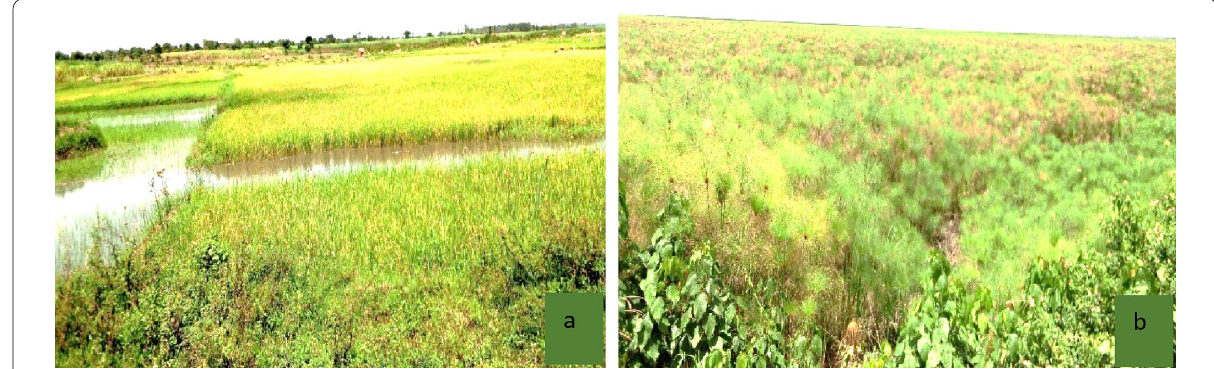
Fig. 6 Parts of Mpologoma wetland, a converted for growing rice; and b intact wetland area